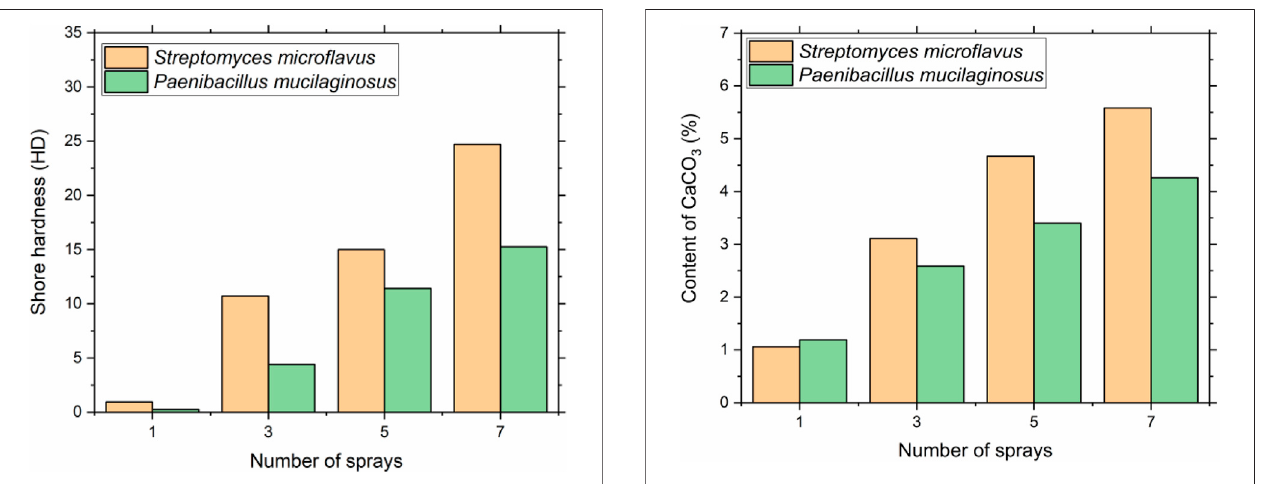
FIGURE 2 | Shore hardness of consolidated sand layers prepared by different spraying times.